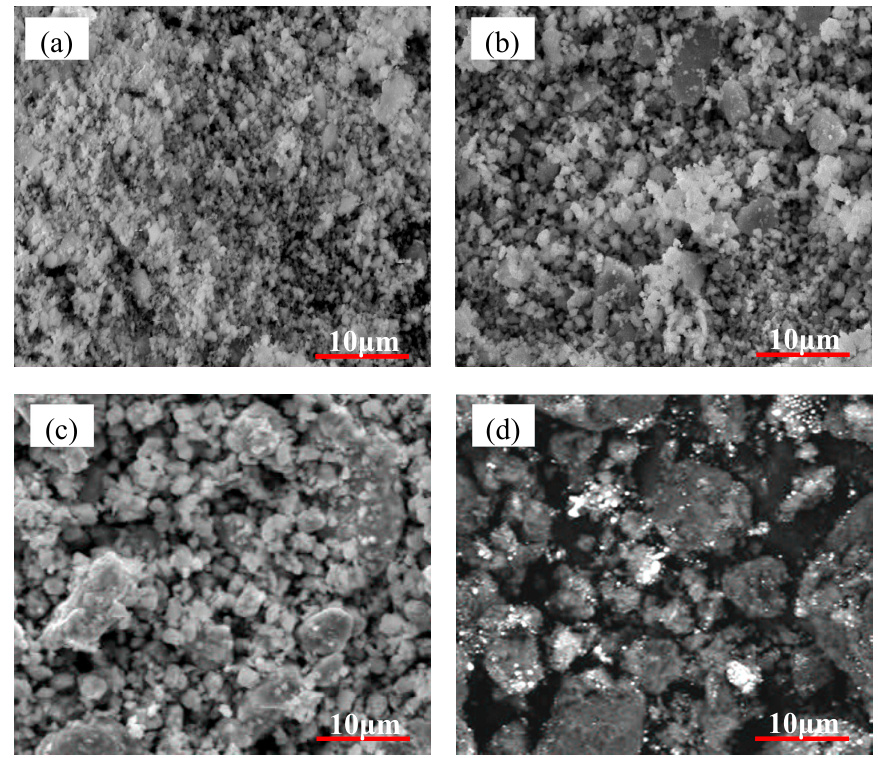
Figure 8. Abrasive dusts morphologies of NiCr/10% hBN composite at ( a ) 25 ◦ C, ( b ) 600 ◦ C, ( c ) 700 ◦ C; and ( d ) 800 ◦ C.